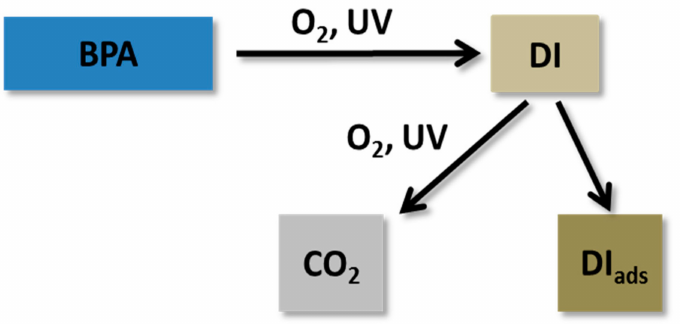
Figure 12. Scheme of several BPA transformation routes (DI—degradation intermediates, DI ads —adsorbed degradation